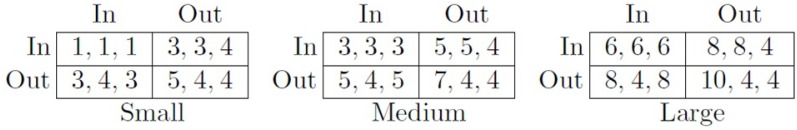
The signaling game with two strategically interacting receivers.